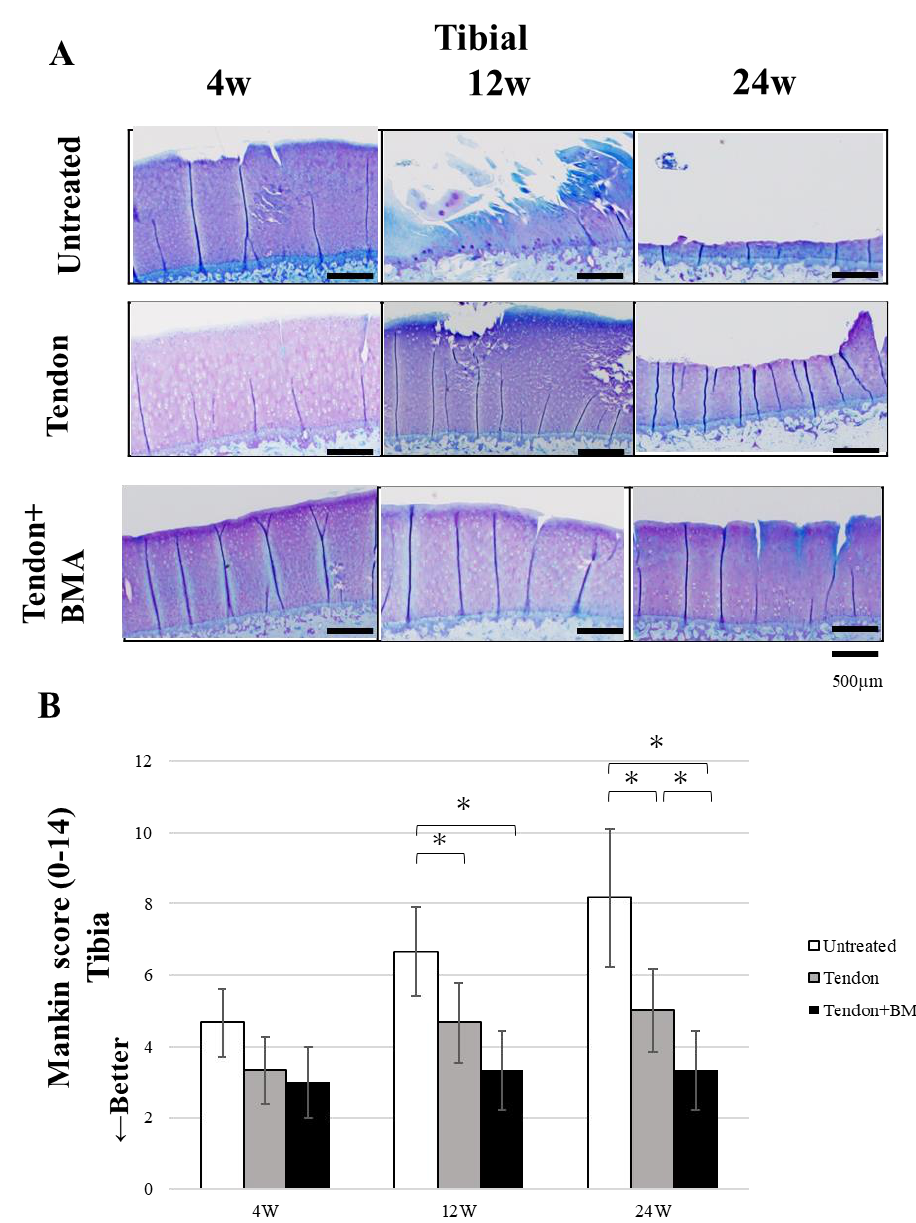
Figure 6. Histological analyses for articular cartilage at the medial tibial plateau. ( A ) Toluidine blue staining of medial tibial plateau cartilage. ( B ) Mankin score. ( n = 6, * p < 0.05). The Mankin score in the tendon + BMA groups was significantly lower than that in the untreated and tendon groups at 24 weeks postoperatively.